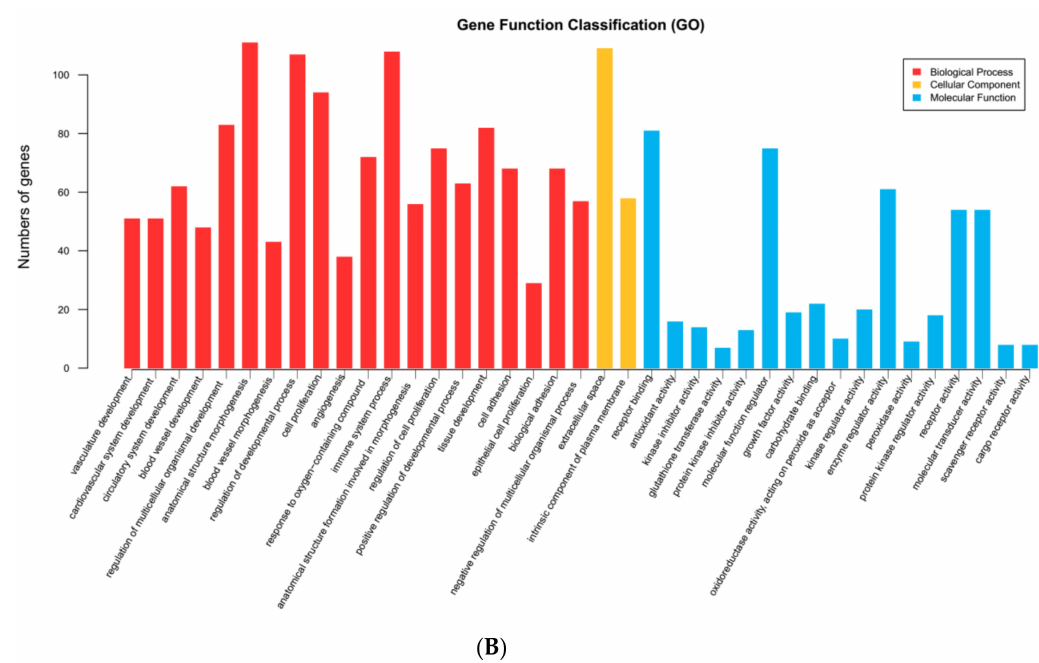
Figure 4. Gene Ontology (GO) annotations of unigenes in the Yan Yellow cattle transcriptome. The figure is composed of three parts: biological processes; molecular functions; and cellular components. The significance level of enrichment was set at a corrected p -value ( p adjust < 0.05). ( A ) GO annotations of unigenes in the early stage of adipogenesis; ( B ) GO annotations of unigenes in the later stage of adipogenesis.